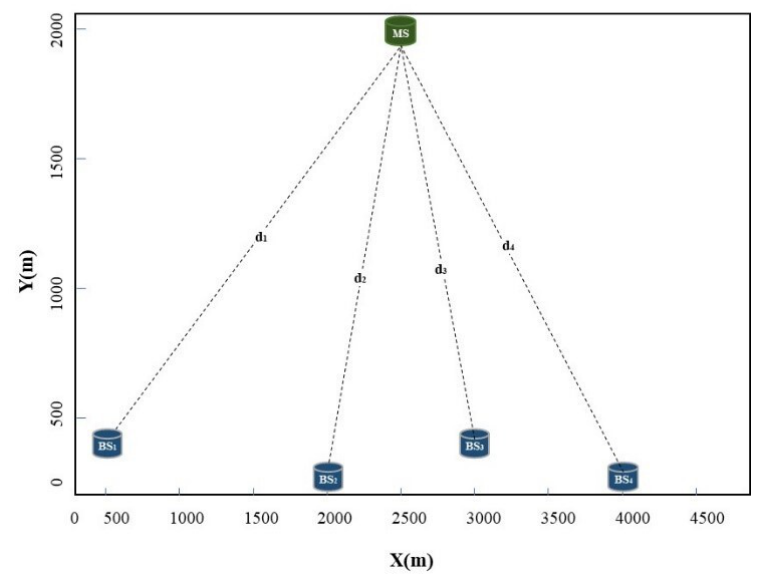
Figure 6. The layout of the BSs and the